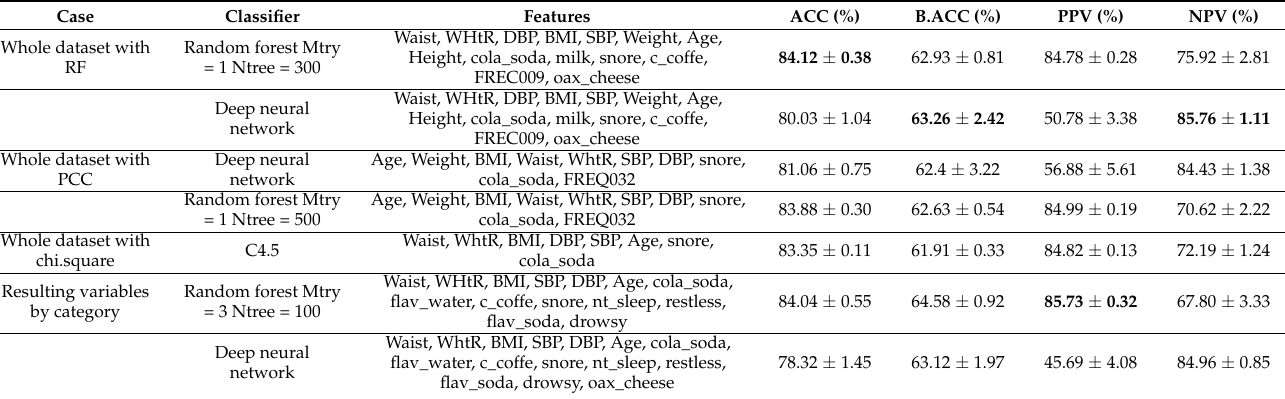
Table 4. Model performance in women.